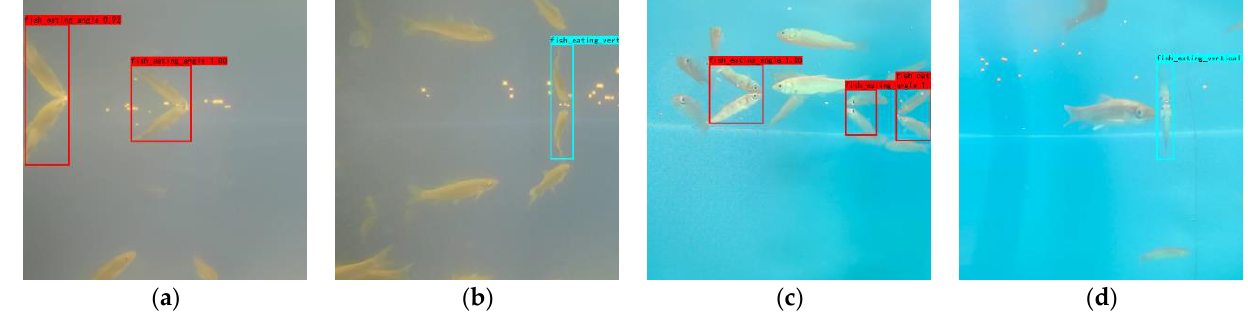
Figure 12. Model recognition effect. ( a , b ) model recognition effects on sunny days; ( c , d ) model recognition effects on cloudy days.